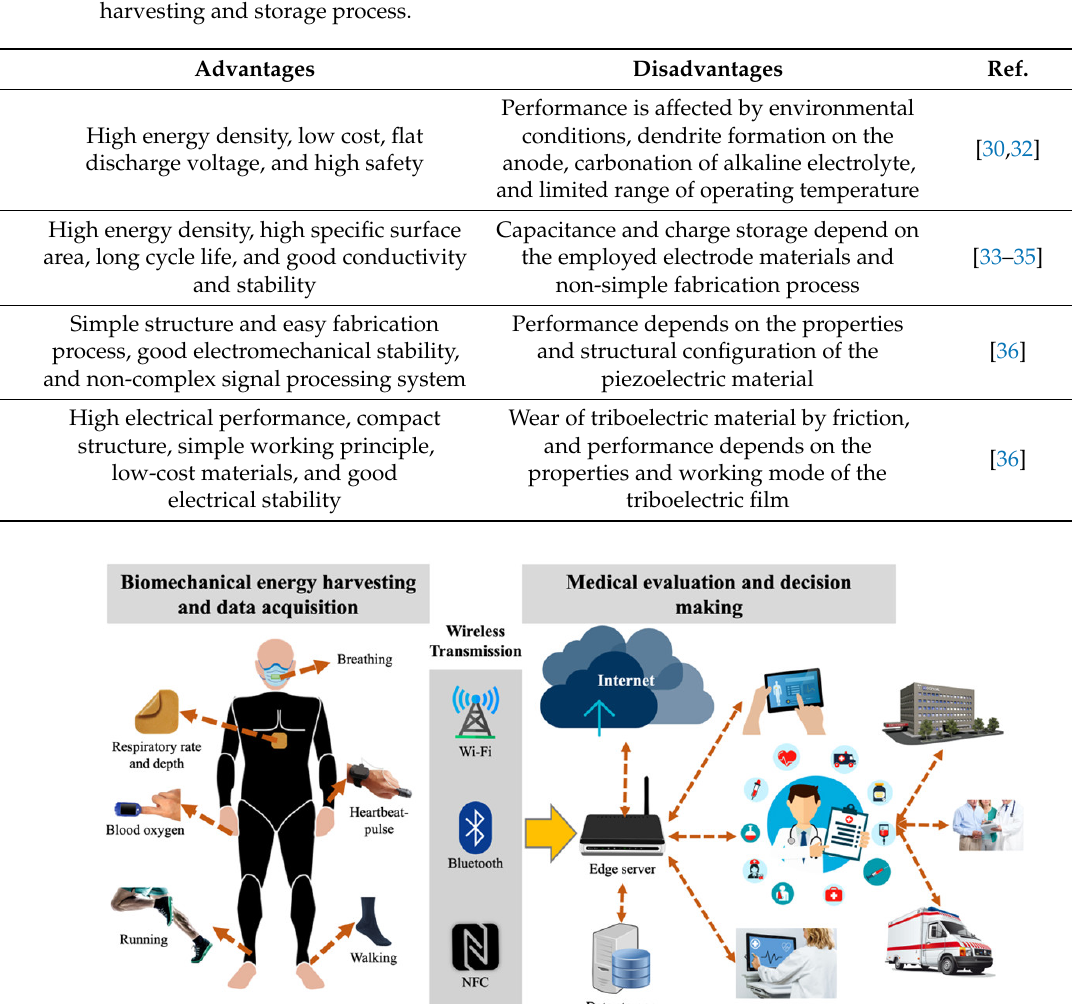
Table 1. Comparison of advantages and disadvantages of different devices used in the energy harvesting and storage process.